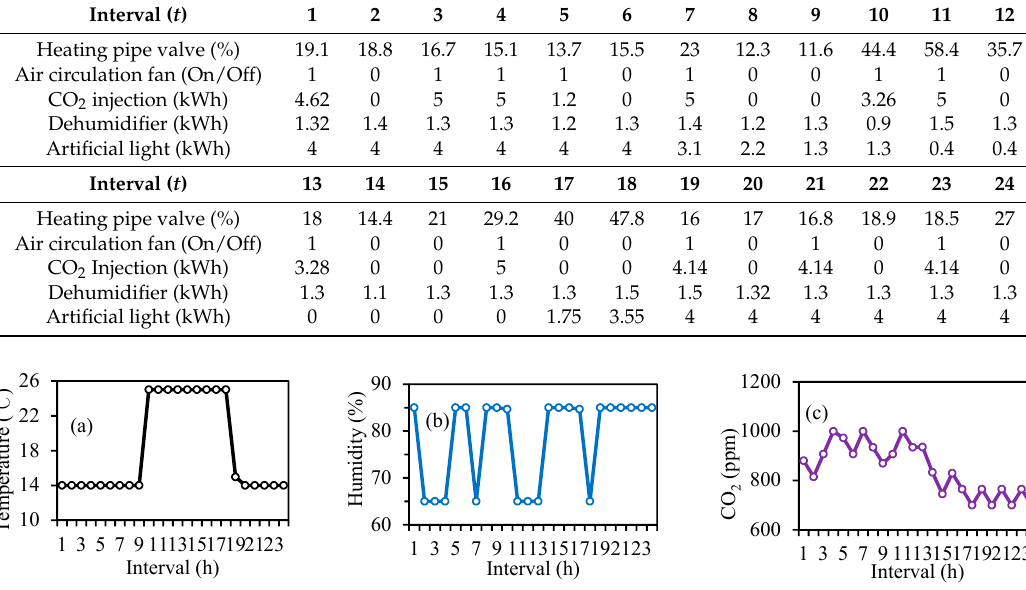
Table 6. Equipment usage for environment control during winter season in greenhouse.